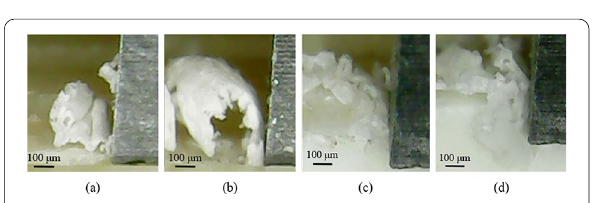
Figure 9 Chip morphologies a h and d h